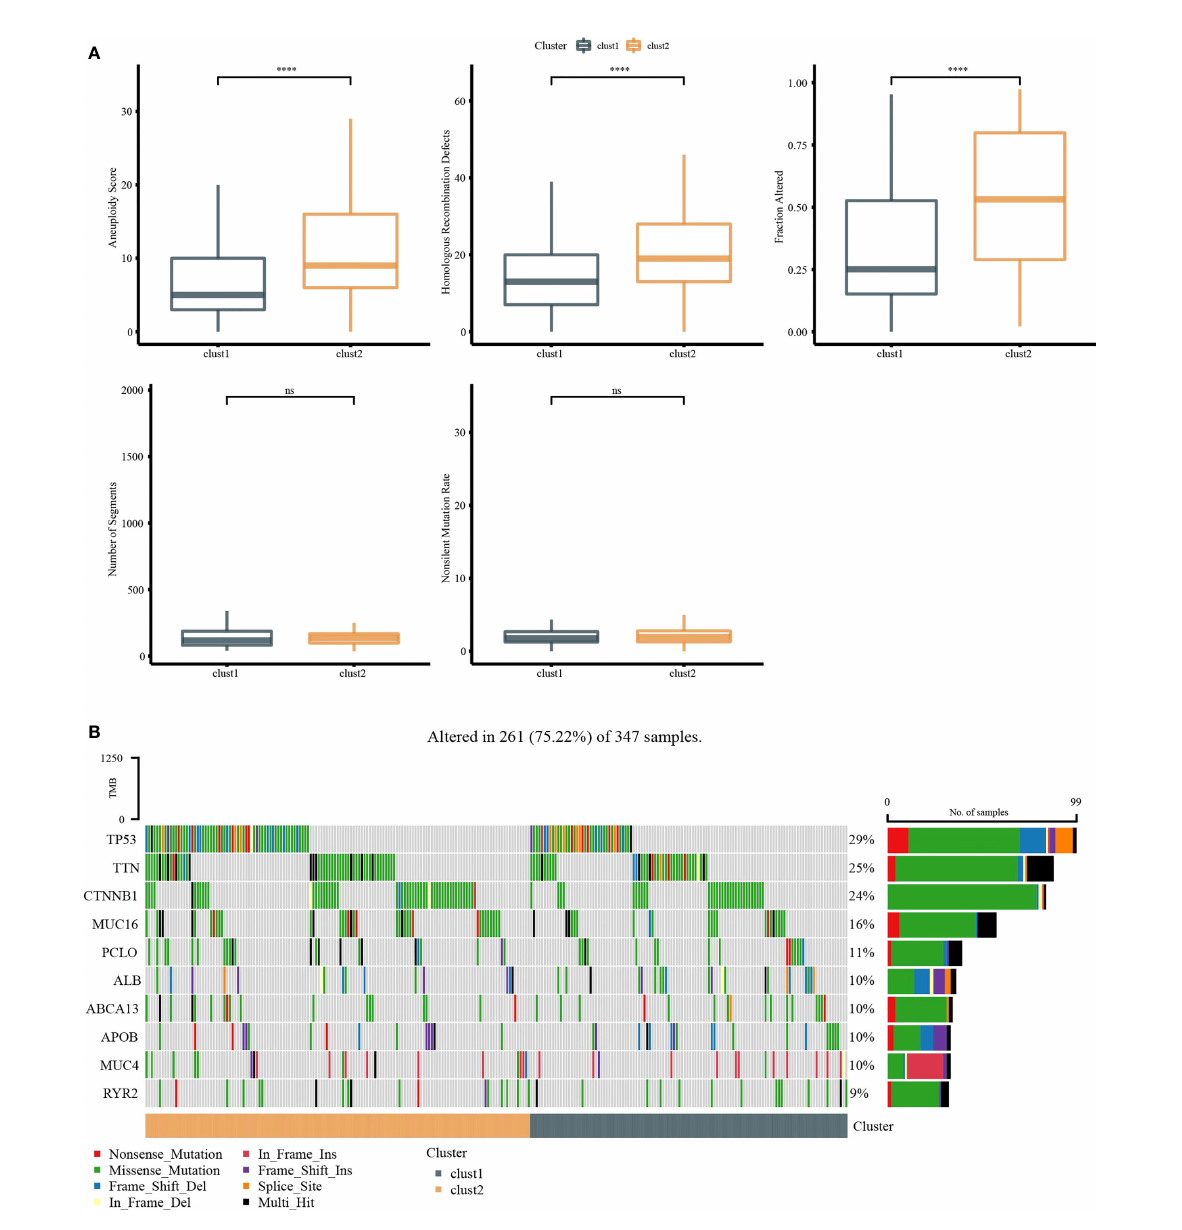
FIGURE 5 Genome analysis. (A) The analysis of aneuploidy score, homologous recombination defects, fraction altered, number of segments, and non- silent mutation rate in Clust1 and Clust2. (B) Top 15 mutation genes in Clust1 and Clust2. ****p<0.0001, ns, no signi fi